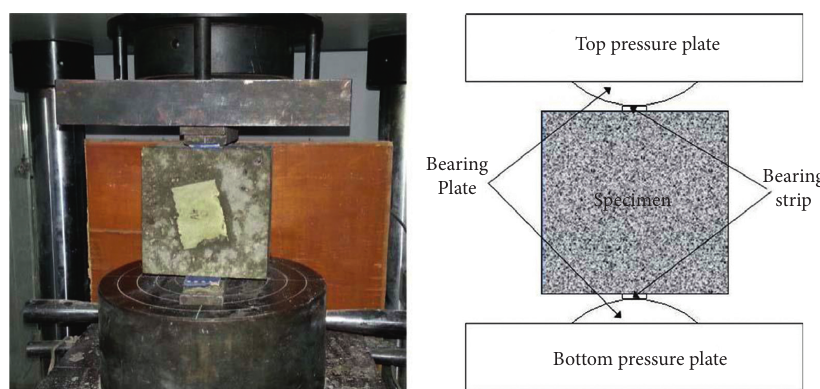
Figure 1: Test setup of splitting tensile strength.